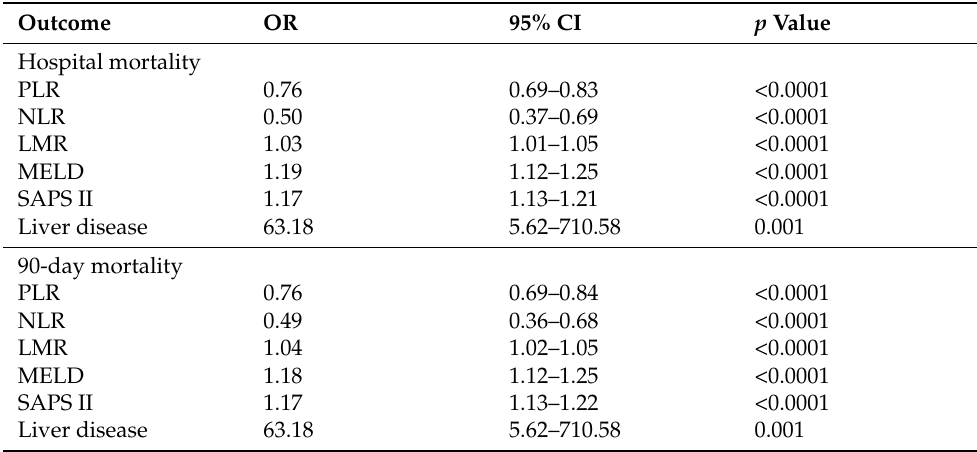
Table 4. Univariate logistic regression analyses for prognosis in newborn patients.